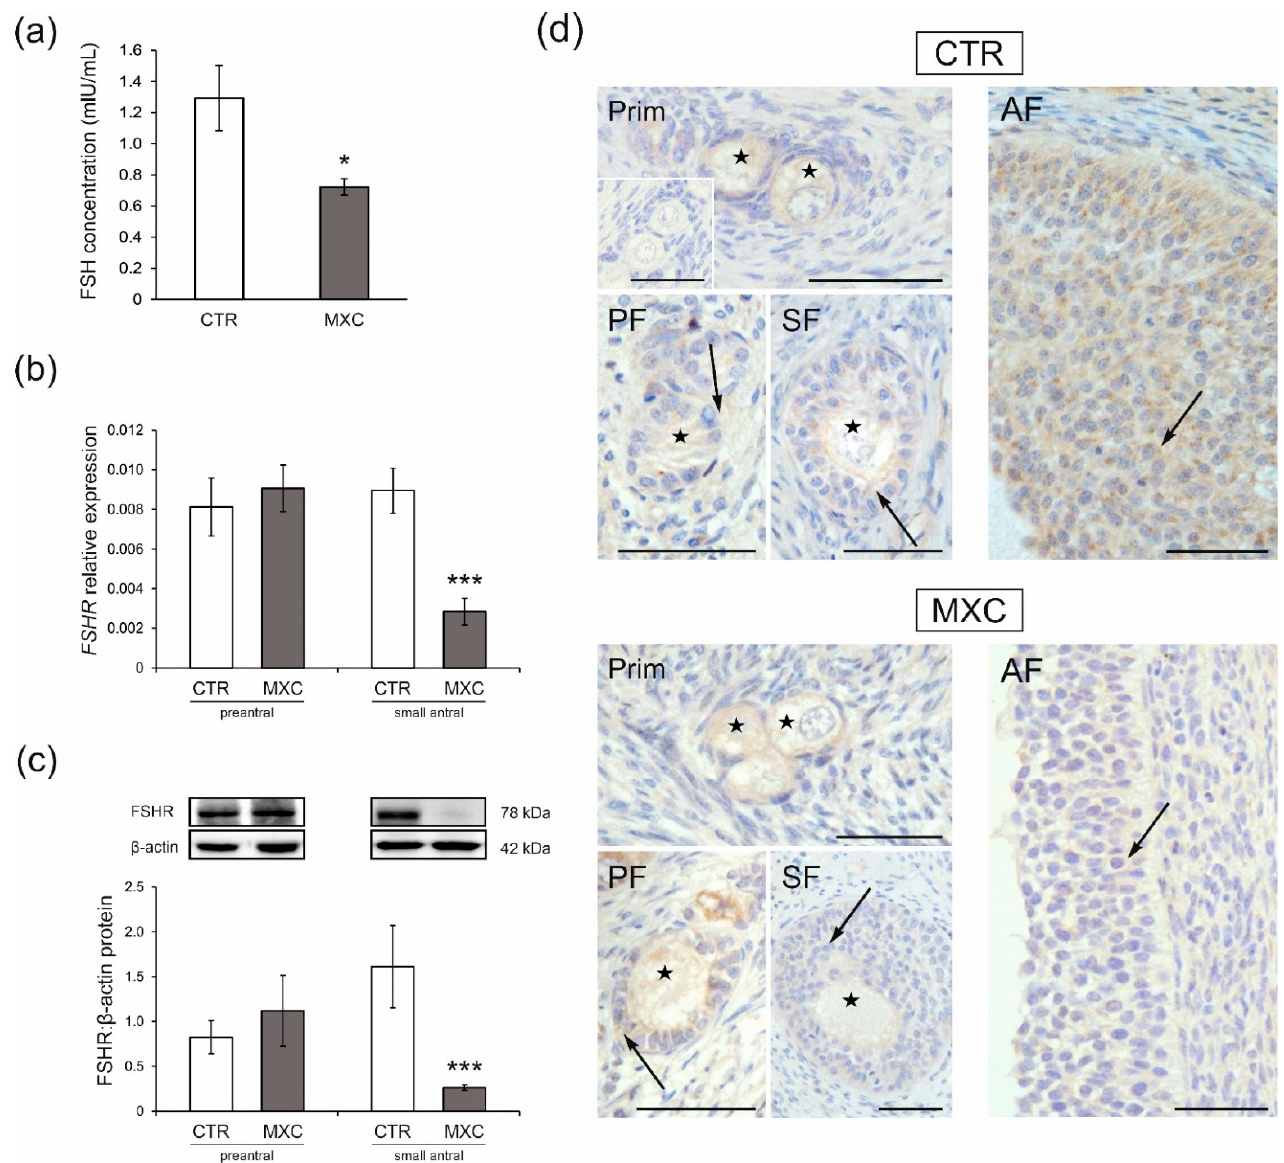
Figure 5. Plasma follicle-stimulating hormone (FSH) concentration in the control (CTR) and methoxychlor (MXC-) treated adult pigs ( a ) ( n = 5 per each group). FSHR ( b , c ) mRNA and protein abundance in preantral (primordial, primary, and secondary follicles), as well as small antral follicles obtained from the CTR and MXC-treated gilts (for preantral follicles pool n = 5, for small antral follicle n = 15). The mRNA expression (quantitative real-time PCR) is presented relative to GAPDH ( b ). Relative protein abundance was measured by the densitometric method and expressed as the ratio relative to β -actin abundance ( c ). Membrane fragments with bands corresponding to predicted molecular weights are shown above graphs. Data are expressed as the mean ± SEM. Asterisks on graphs denote significant differences between the CTR and MXC-treated animals (* p < 0.05, *** p < 0.001, Mann–Whitney U test). ( d ) Localization of FSHR in preantral (primordial, primary, and secondary follicle) and small antral follicles of the CTR and MXC-treated pigs. FSHR immunopositivity was observed in oocytes (asterisks) and granulosa cells (arrows) of preantral follicles, as well as granulosa cells (arrows) of small antral follicles, in both examined groups. Hematoxylin QS was used for counterstaining sections. There was no positive staining observed in the negative control section ( d , insets). Prim—primordial follicles; PF—primary follicles; SF—secondary follicles; AF—antral follicles. Bars = 50 μ m.